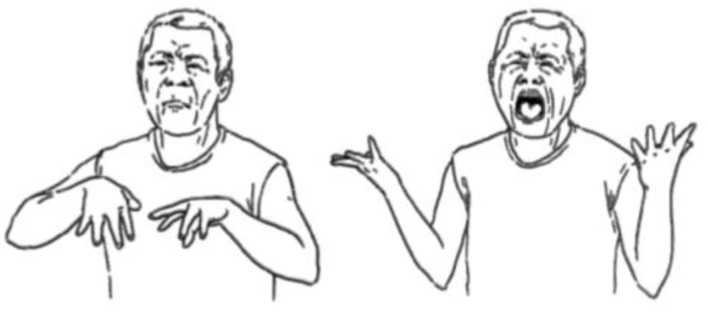
Mouth gesture ‘pah’ in Kata Kolok (from De Vos, 2012) [reproduced with permission].